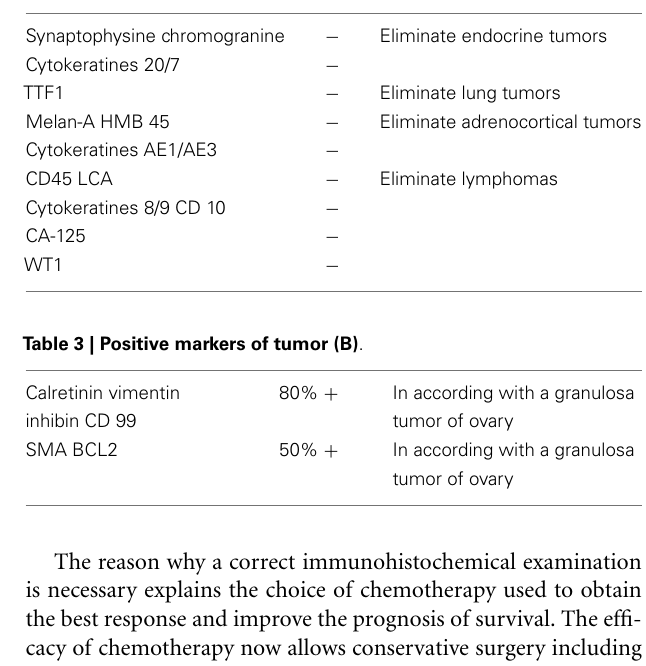
Table 2 | Negative markers of tumor (B) .